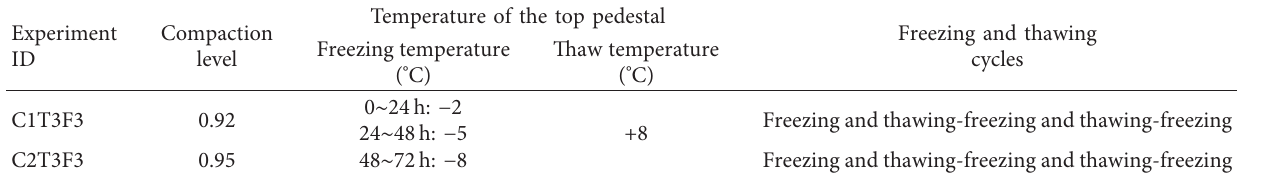
Figure 3: Semilog plot of particle-size distribution of CGS collected from Harbin–Qiqihar HSR subgrade. Table 2: Freezing and thawing test scheme under open water supply system conditions.